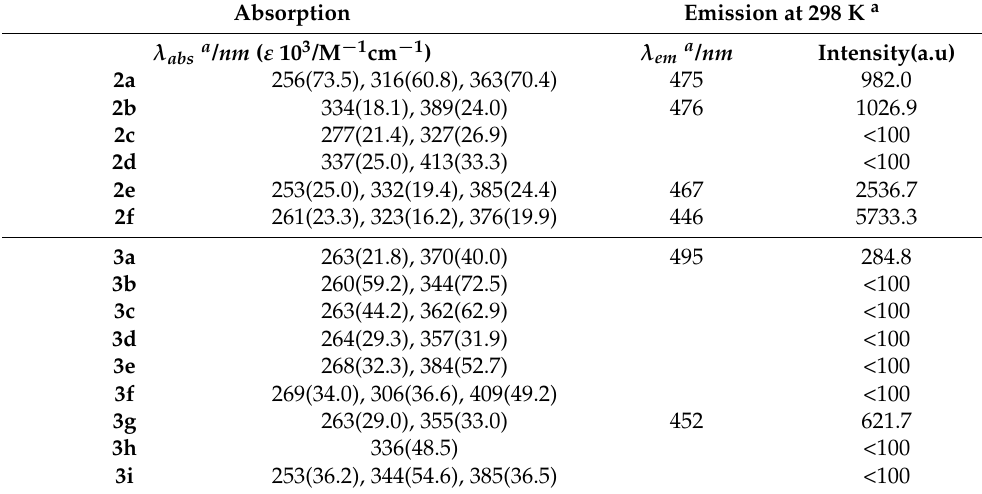
Figure 2. Emission spectra of the monoarylated DPDTEs ( 2a - f ) ( a ) and diarylated DPDTEs ( 3a - i ) ( b ) in CHCl 3 at 298 K (C = 10 − 5 M) with λ ex = 360 nm. Table 2. Photophysical data of the arylated DPDTE ( 2a – f , 3a–i ).